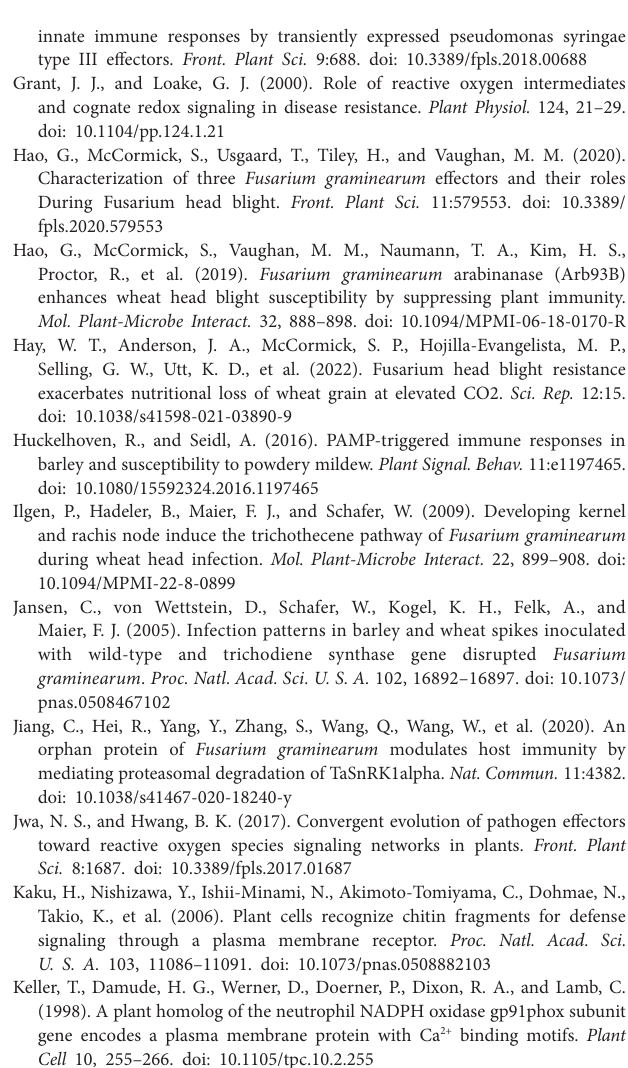
Supplementary Figure S2 | No ROS burst detected in wheat leaves treated with various chitin concentrations. Wheat cultivar Norm leaves were treated with chitin concentrations of 100, 500, 1,000, and 2,000 μ g/ml, respectively. Leaves were collected from 7- to 12-day old plants. Barley cultivar Golden Promise leaves treated with chitin (100 μ g/ml) served as a positive control. Wheat leaves without chitin served as a negative control. ROS were monitored using a chemiluminescence assay with L012 as a substrate. The plates were run on a 96-well plate reader and signals (RLU) were recorded for about 40 min. The data represent means ± standard error ( n = 12). The experiments were repeated twice with similar results. Supplementary Figure S3 | FHB symptoms in wheat cultivars inoculated with F. graminearum strain. Point inoculation (10 μ l spore suspension containing 1,000 conidia) was performed on wheat florets with F. graminearum wild-type PH- 1. Photographs were taken 21 days post-inoculation (dpi). Supplementary Figure S4 | No effect on ROS burst in rachis nodes treated with DON. Rachis nodes were removed from flowering heads and treated with 50 or 100 μ g/ml DON overnight. The DON solution was replaced with ROS assay solution. Chitin (100 μ g/ml) was used in the assay. ROS were monitored using a chemiluminescence assay with L012 as a substrate. Signals (RLU) were recorded for 60 min after treatment. The data represent means ± standard error ( n = 12) for each treatment. The experiments were repeated twice with similar